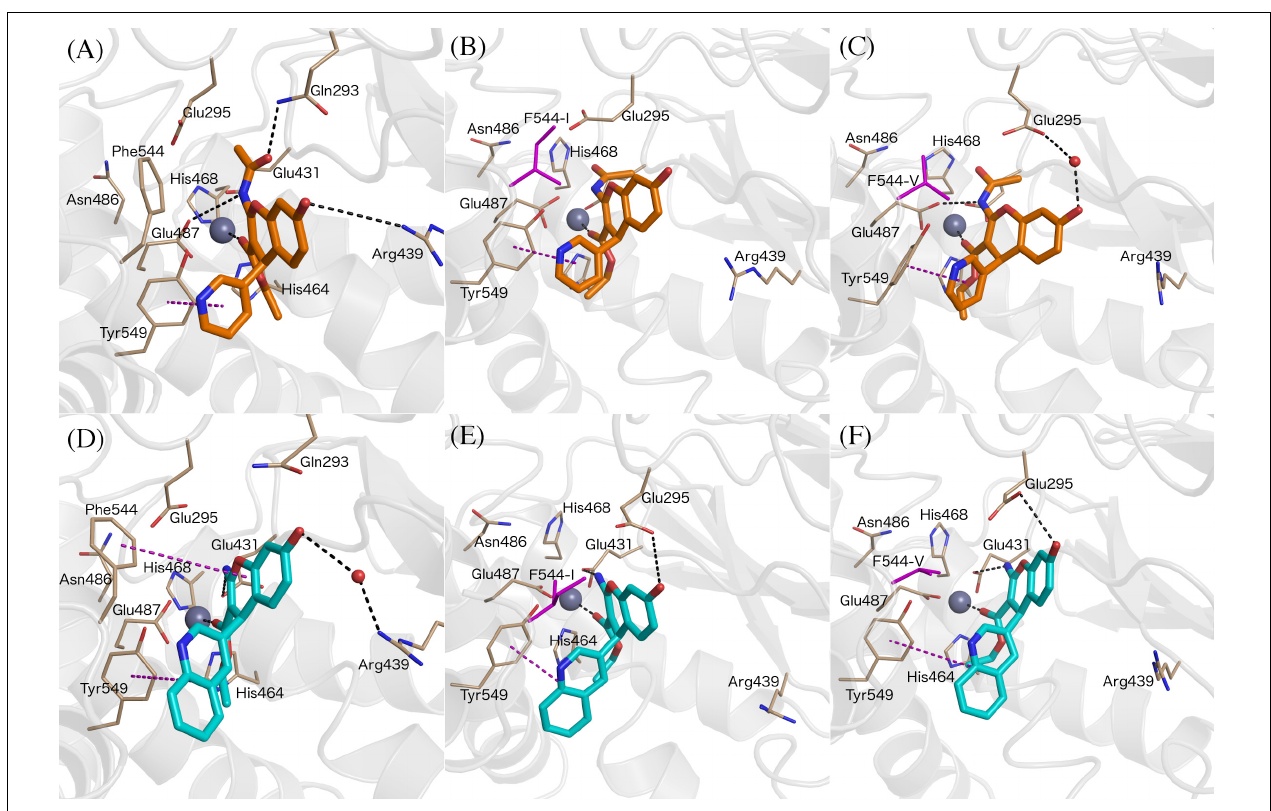
FIGURE 6 | Binding modes of compound 8 ( A , orange sticks) and 7 ( D , cyan sticks) in wt-IRAP active site determined by FEP simulations. Binding mode of compound 8 in F544I (B) and F544V (C) . Binding mode of compound 7 in F544I (E) and F544V (F) . All of the figures shown are extracted from representative snapshot simulations. Residues playing a role in ligand binding are explicitly shown, while residues F544I and F544V are represented in magenta color. The remaining atom representations and protein-ligand interactions following the scheme as in Figure 3